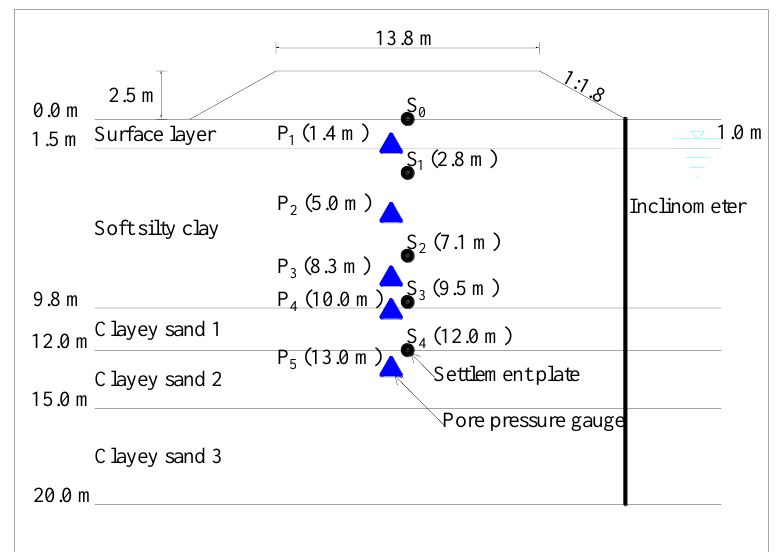
Figure 3. Cross section of the embankment and key instrumentation points of Embankment A. (adapted from [6]).